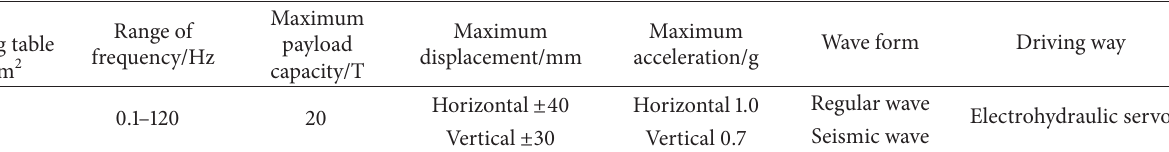
Table 2: Specific technical characteristic parameters of shaking table.